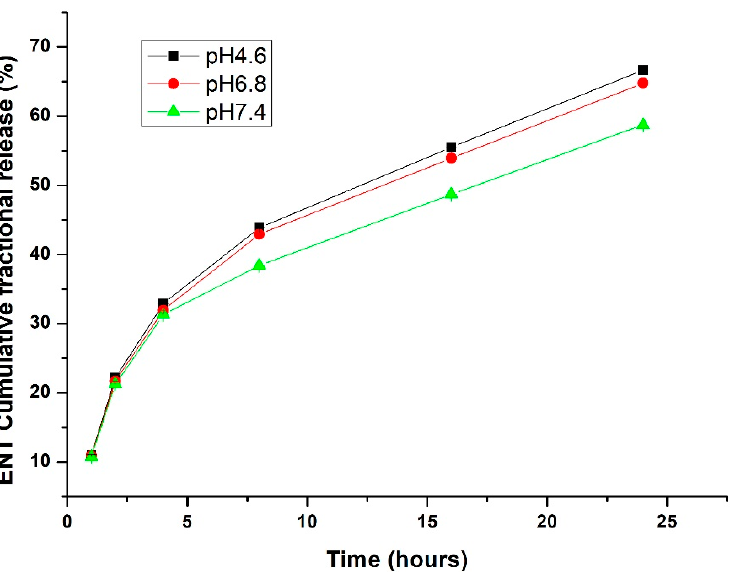
Figure 3. In vitro ENT release from the Lyp-1-functionalized ENT-loaded nanosystem. A relative increase in ENT was released from the LyP-1-functionalized nanosystem at acidic pH of 4.8 of the tumor microenvironment than at normal physiological pH of healthy cells.